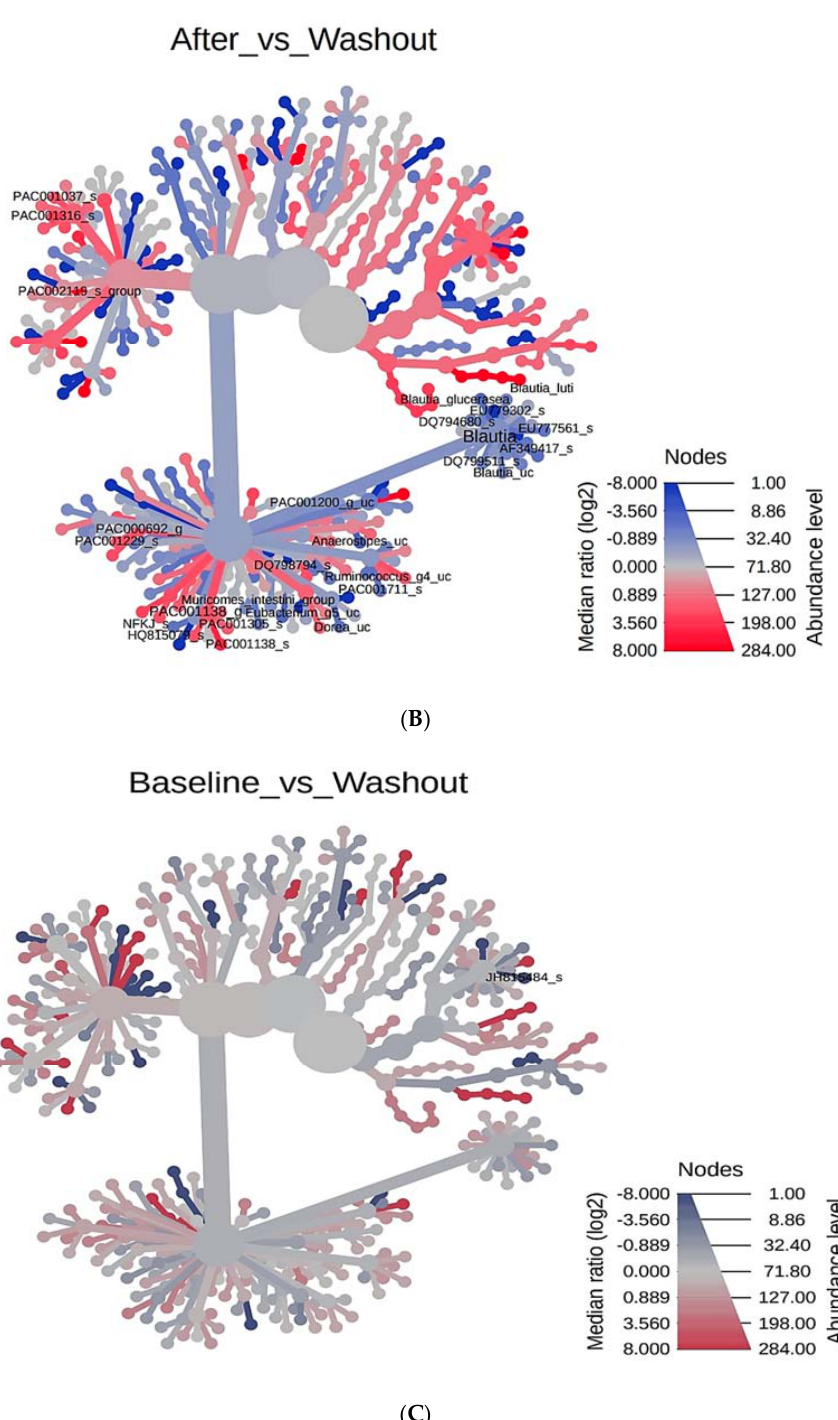
Figure 3. Wilcoxon single rank sum test_Heat tree. For pairwise comparisons with two or more groups, we used a heat tree, a graphing technique called a heat tree matrix. Heat tree of factor Space. Heat Trees report the effect of the presence of vitis vinifera roots on hierarchical structure of taxonomic classifications (median abundance, non ‐ parameter Wilcoxon Rank Sum test). ( A ) Comparison between Baseline and After. ( B ) Comparison between After and Washout. ( C ) Comparison between baseline and washout. Each picture is marked with a different color for the level of abundance. Marked in red, it means that the value of the Median ratio (log2) increases and the abundance is high. On the other hand, indicated in blue indicates that the Median ratio (log2) is decreased and the abundance is